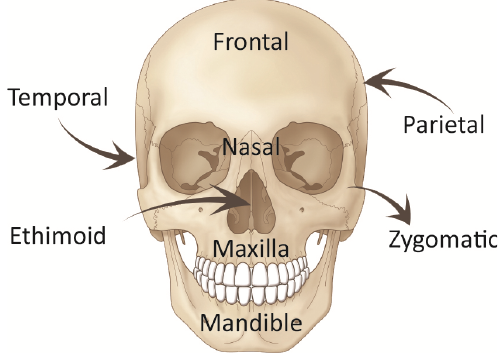
Figure 3. Basic facial skeleton anatomy.